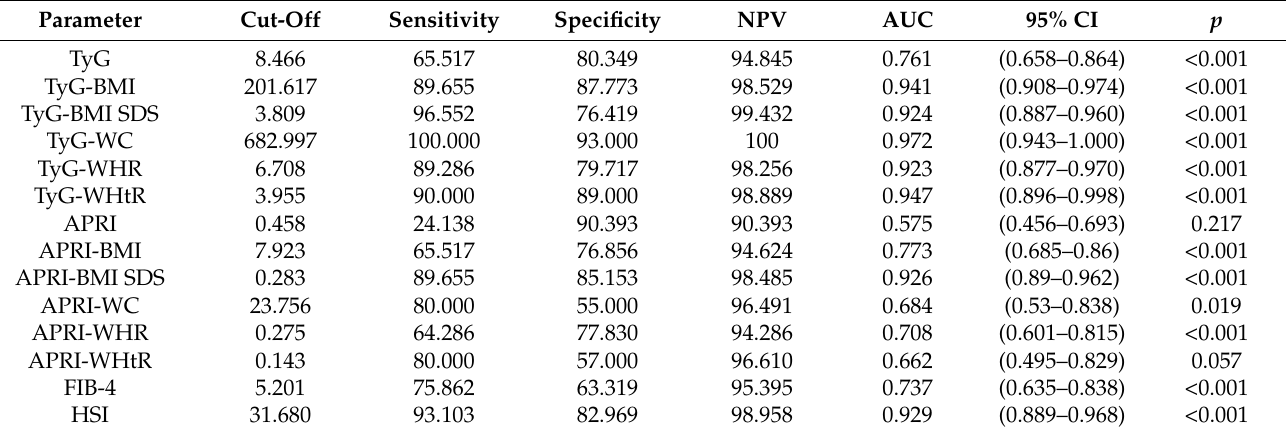
Table 3. Cut-off values and areas under the receiver operating characteristics curves for each parame- ter for predicting insulin resistance.